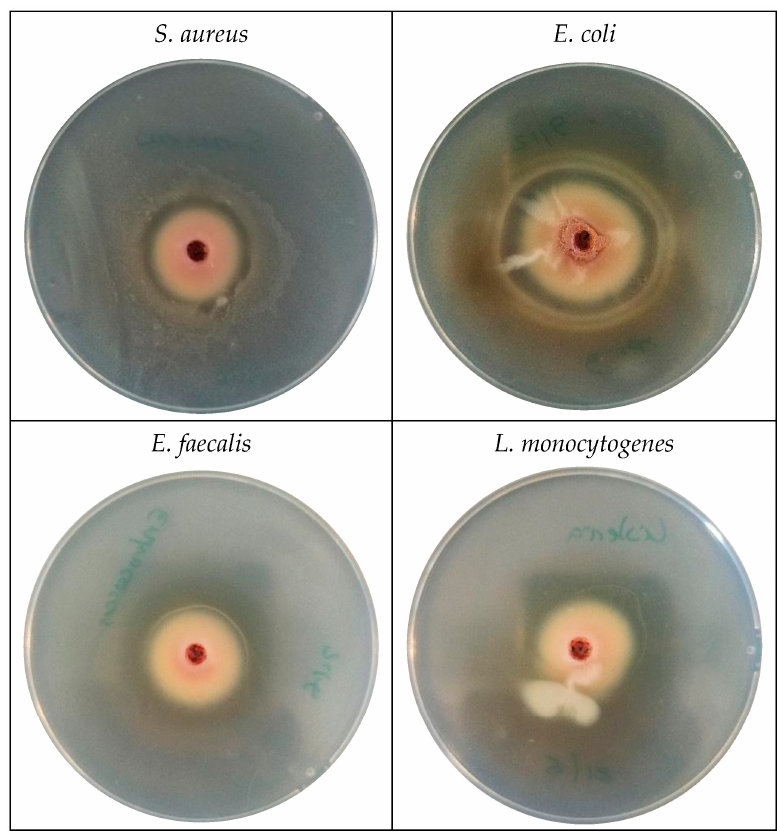
Figure 5. Antimicrobial activity of the pomegranate extract. Table 6. Antimicrobial activity of the control (PLA) and active (PLA/3PPE and PLA/3PP) films.